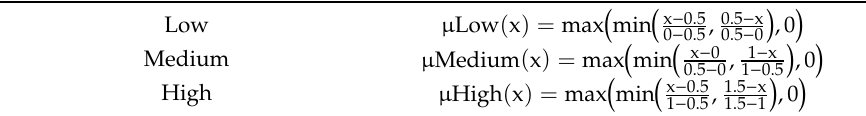
Table 1. Mathematical representation of the input membership functions.